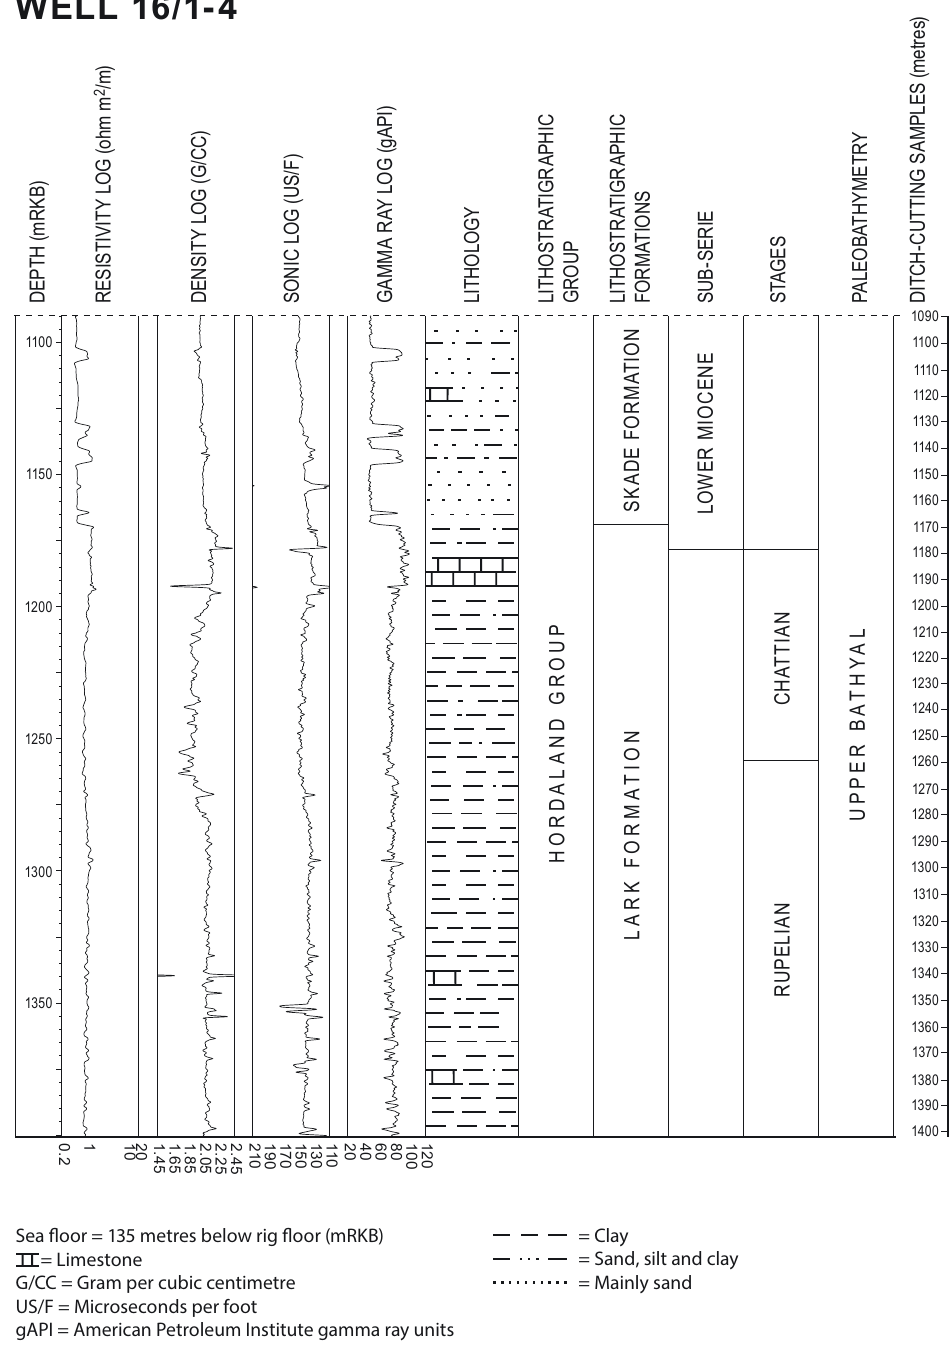
Figure 45. Well summary figure including resistivity log, density log, sonic log, gamma-ray log, lithology, litho- stratigraphic units, sub-series, stages, paleobathymetry and analysed samples for the lower part of the investigated sequence in well 16/1–4 (Rupelian to lower Miocene) including the supplementary well reference section for the Skade Formation (lower part; modified after Eidvin et al.,